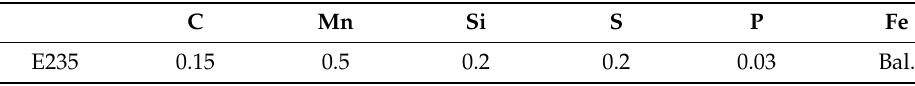
Table 3. Optimization experiment of temperature parameters of cold spraying.